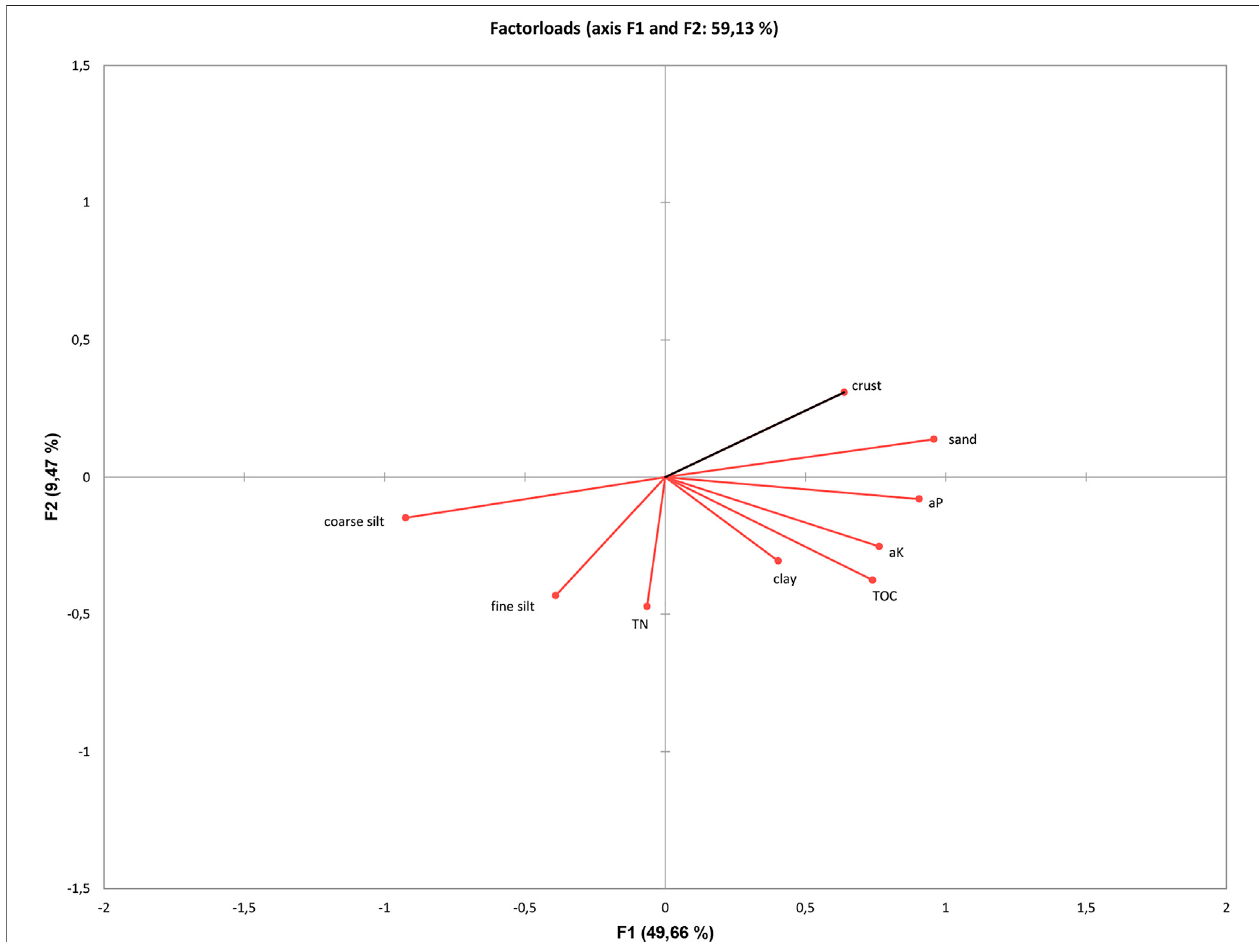
FIGURE6| Ordinationdiagramofeffectiveselectioncriteriaincrustgrowthextractedbyprincipalcomponentanalysisofninesoilvariables(arrows)sampledatthe Hochtor. TOC, total organic matter content; TN, total nitrogen; aP, available phosphorous; and aK, available potassium.